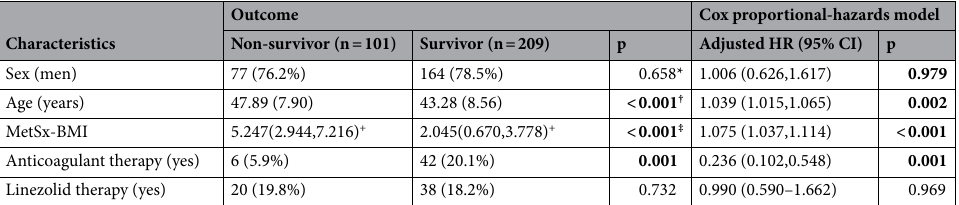
Table 9. Risk factors associated with mortality in patients hospitalized with COVID-19. HR hazard ratio, CI confidence interval. + Quartile 2(Quartile 1, Quartile 3). *Chi-squared test. † t-test. ‡ Median test. Significant p-values are in